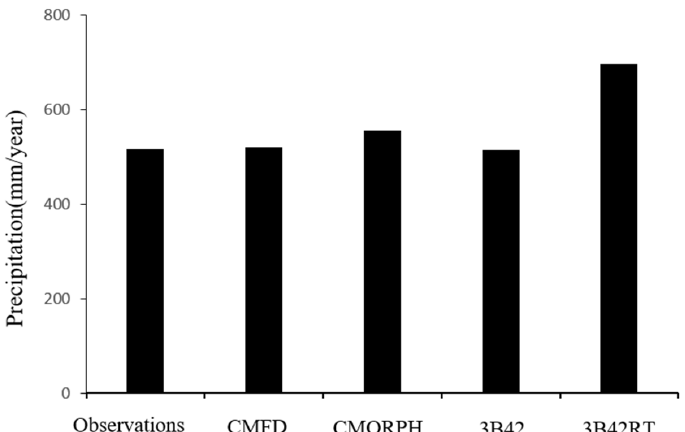
Figure 6. The annual differences between ground observations and each satellite precipitation dataset from 2001 to 2015 are shown in Figure 7.